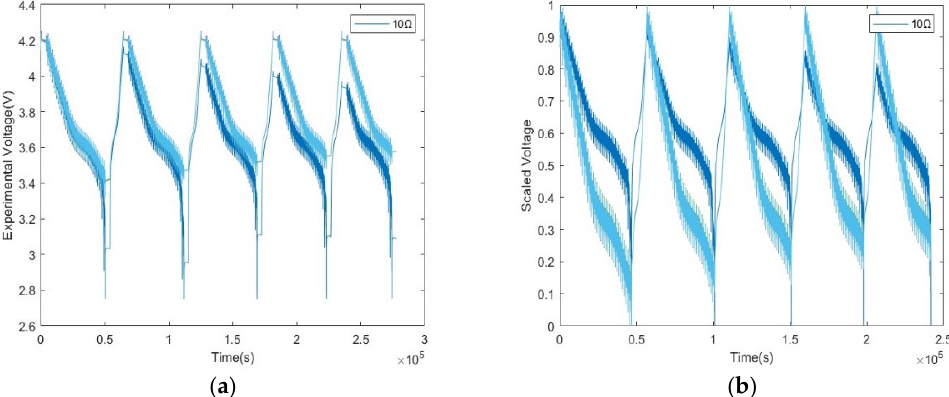
Figure 10. The laboratory battery pack voltage characteristic curve with an ISC resistance of 10 Ω : ( a ) Voltage curve of ISC; and ( b ) Normalized voltage curve.